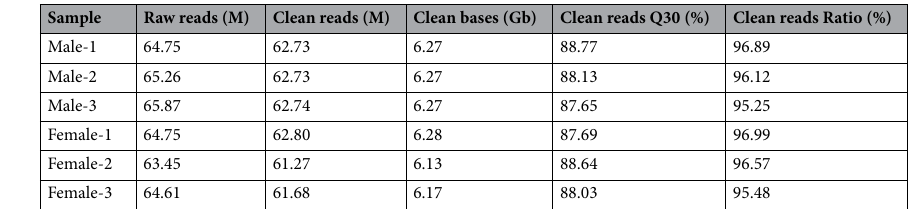
Table 1. Summary statistics for the transcriptome sequencing data from each